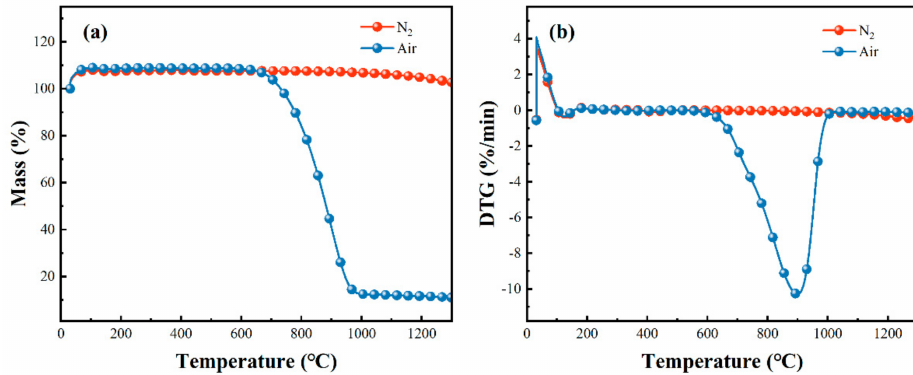
Figure 2. TG curve ( a ) and DTG curve ( b ) of carbon fibers in nitrogen and air atmospheres.